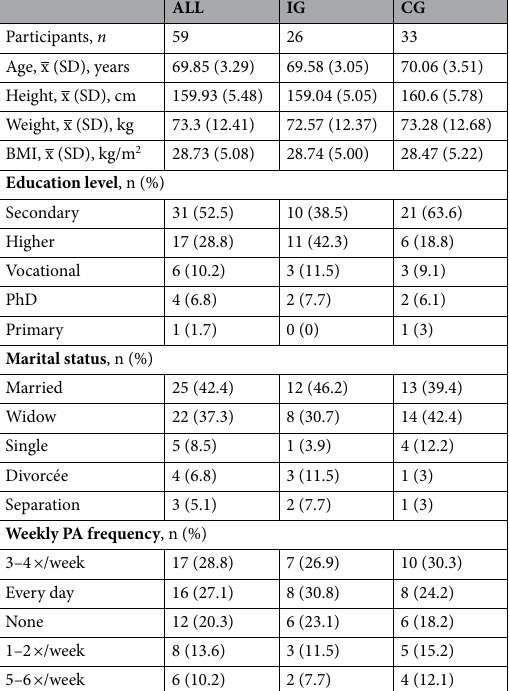
Table 2. Descriptive characteristics of the female participants, whose results were statistically analysed. IG Intervention Group, CG Control Group, n number of observations, x mean, SD standard deviation, PA physical activity.